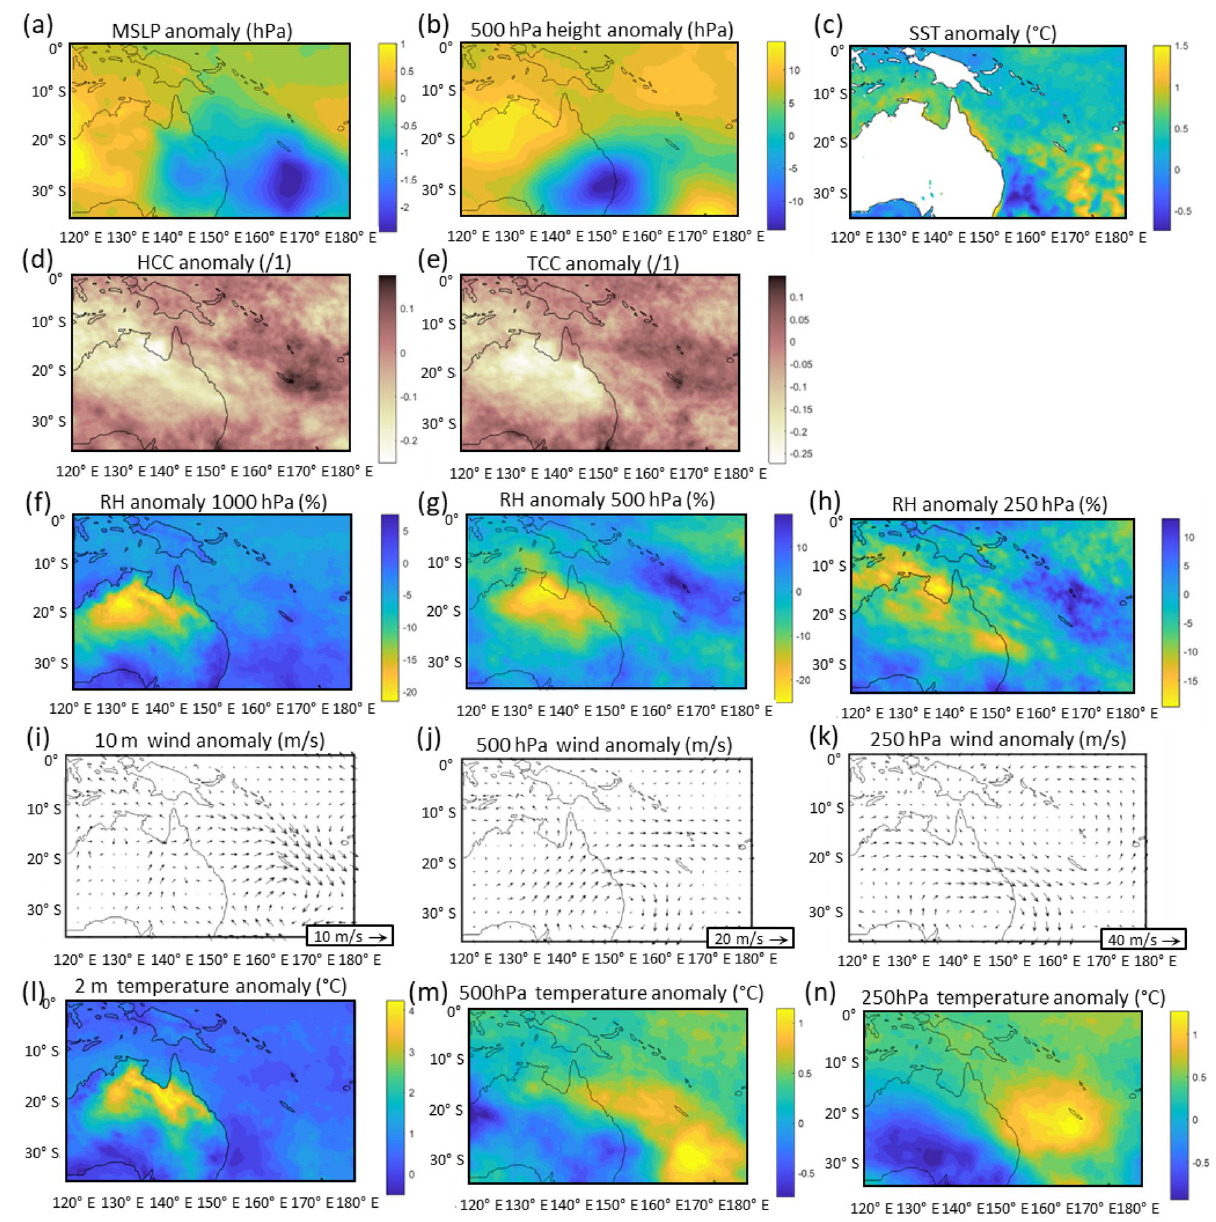
Pressure ( a ); 500 hPa height ( b ); Sea Surface Temperature ( c ); High cloud cover > ~ 500 hPa ( d ); Total cloud cover surface to ~ 500 hPa ( e ); Relative humidity at 1000 hPa, 500 hPa and 250 hPa ( f – h ); Wind at 10 m, 500 hPa and 250 hPa ( I – k ); Temperature at 2 m, 500 hPa and 250 hPa ( I – n